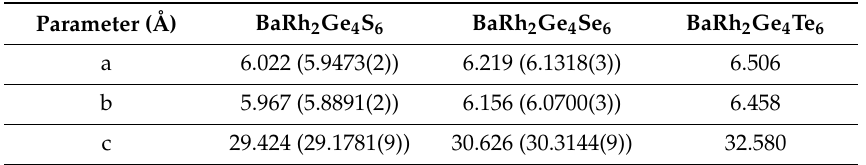
Table 1. Optimized crystallographic parameters of the BaRh 2 Ge 4 X 6 (X = S, Se, Te) structures (experimental parameters in parenthesis from [25]).